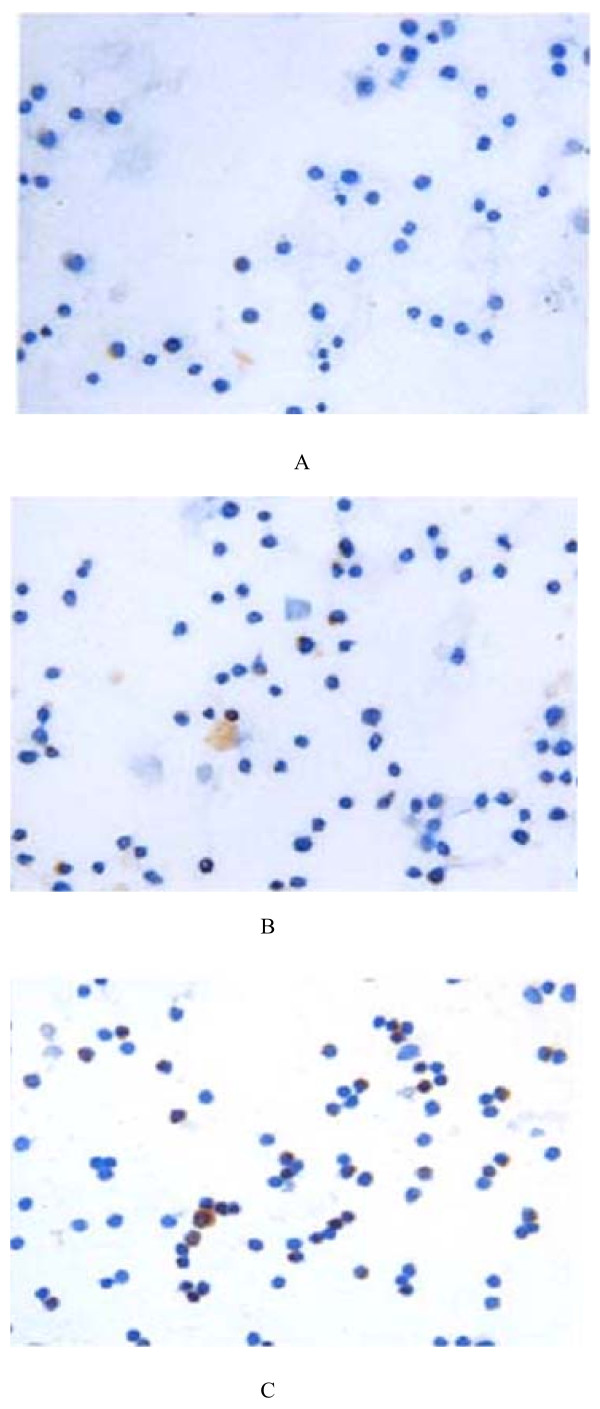
Expression of p-PYK2 in PBMCs from SLE patients. Detection of p-PYK2 protein in PBMCs from healthy donors (n = 24), patients with RA (n = 32), and patients with SLE (n = 48) was performed by immunocytochemistry technique using specific anti-p-PYK2 Abs. p-PYK2 was weakly positive in PBMCs from healthy donors (A) and RA patients (B). An increase in the positive staining for p-PYK2 was observed in PBMCs from SLE patients (C). Original magnification, × 400. Experiments were repeated at least three times with similar results.